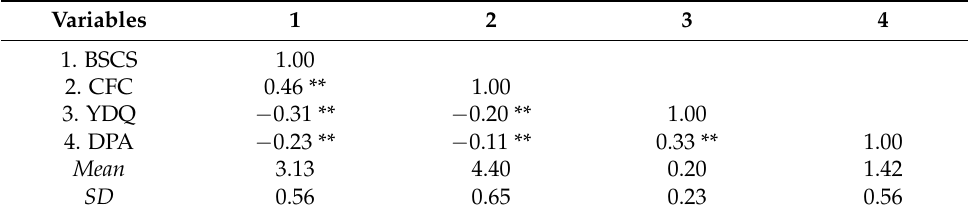
Table 1. Descriptive statistics and correlations for all variables.